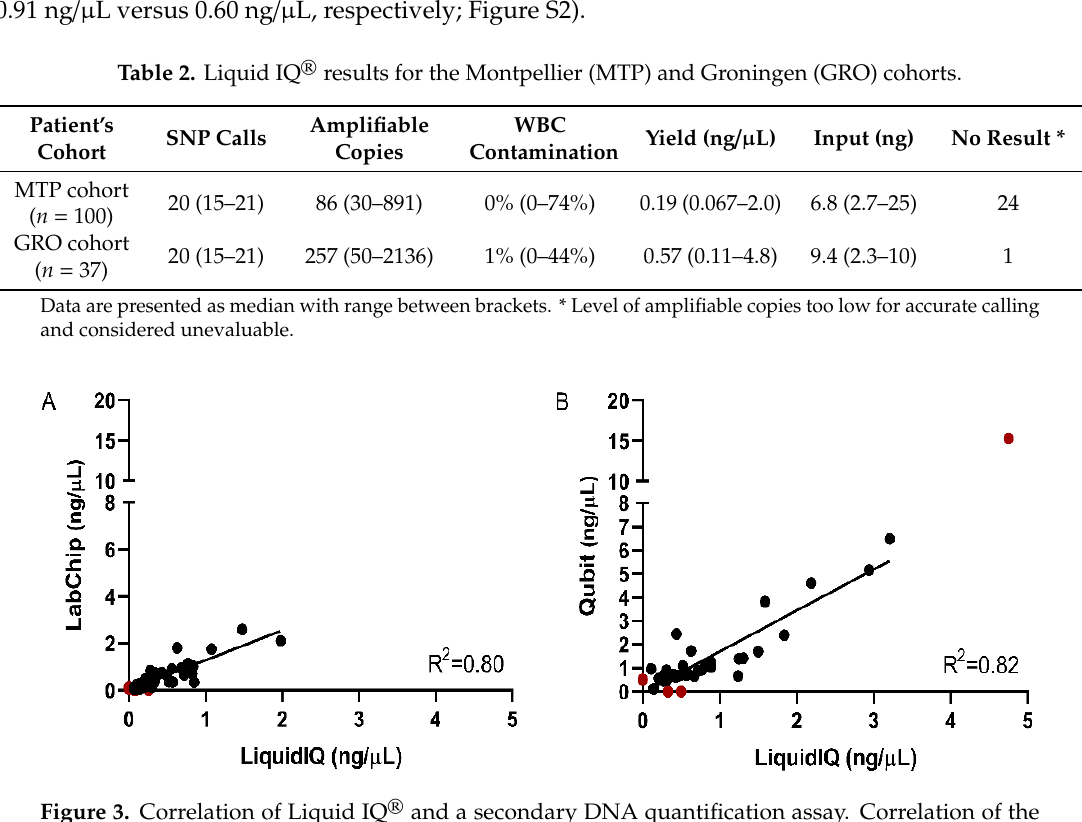
Figure 3. Correlation of Liquid IQ ® and a secondary DNA quantification assay. Correlation of the ccfDNA concentration as determined by the amplifiable copies measured with Liquid IQ ® and the quantification based on ( A ) LabChip ® performed on the samples of the MTP cohort and ( B ) Qubit ™ performed on the samples of the GRO cohort. Red-colored results are not included in the correlation due to failure of either quantification assay or was considered an outlier.